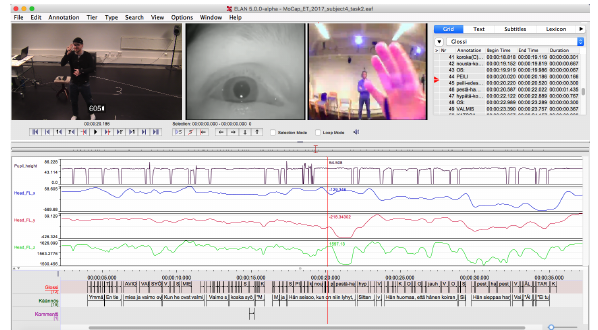
Figure 8. Screenshot of the ELAN multimedia annotation soft- ware. The upper part of the screen shows video data from the external video camera as well as from the pupil and field camera. The descriptors in the middle visualize the pupil height data (the upmost panel) and the three-dimensional marker location data derived from the front left head marker (the three bottom panels). The markings on the three tiers at the bottom of the screen are annotation cells time-aligned with the video